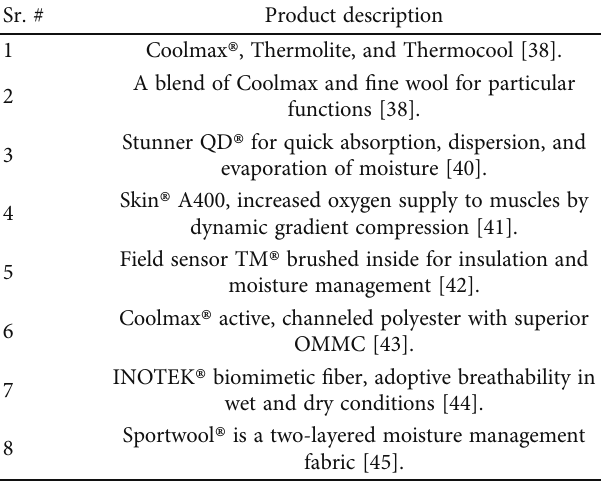
Table 1: Some advanced and innovative commercial products for